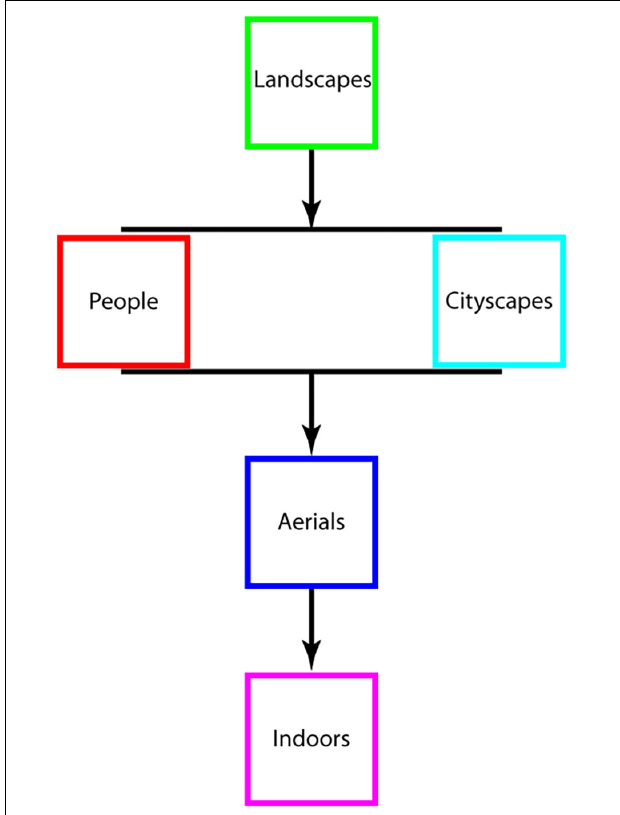
FIGURE 7 | Schematic illustrating the hierarchy of image interestingness revealed by our